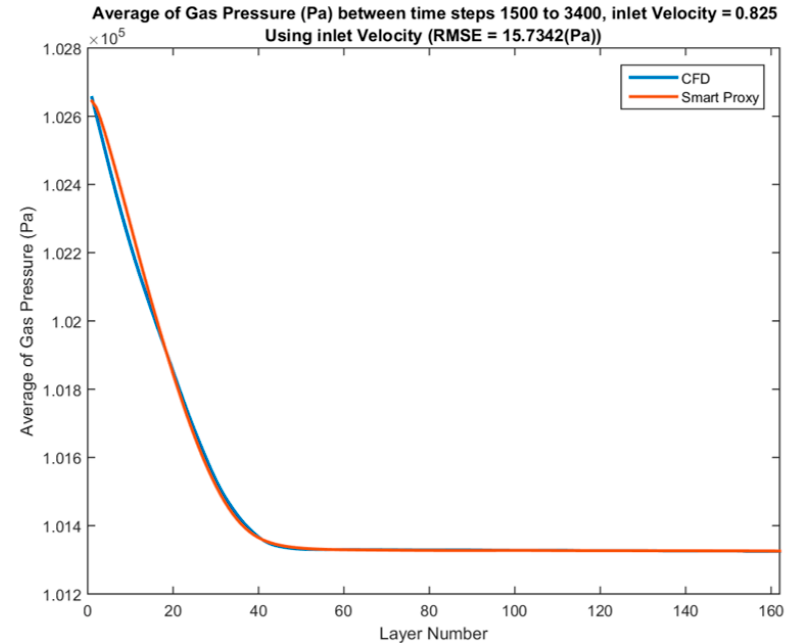
Figure 50. Spatial average profile of CFD and smart proxy results for gas pressure (Pa) averaged over time-steps 1500 to 3400 for blind test condition of V in = 0.825 m/s.